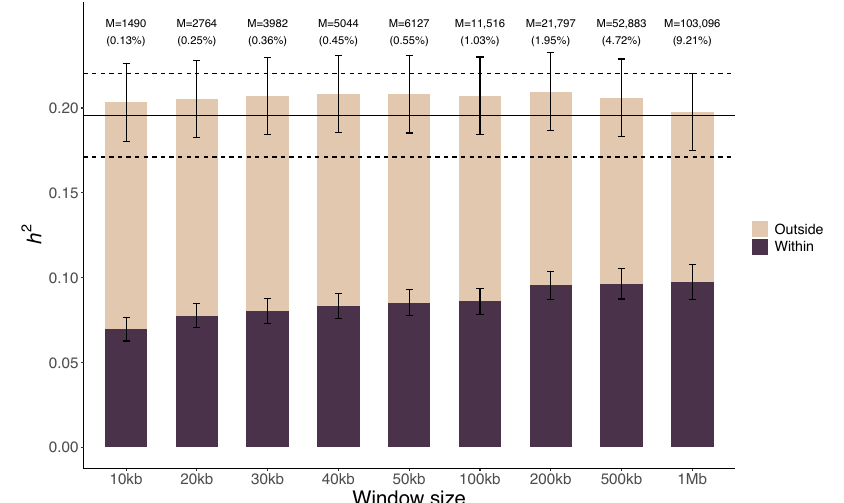
Fig. 4 | Partitioned SNP-based heritability of FG in the vicinity of 156 glucose- associated SNPs. Estimates of SNP-based heritability ( h 2 ) were obtained in the Lifelines sample ( N =13,781) by partitioning the genome into SNPs within genome- widesigni fi cantlocivs.SNPsoutsideofgenome-widesigni fi cantloci.Errorbarsare standard errors (s.e.). Horizontal lines (dotted=estimate±standard error)